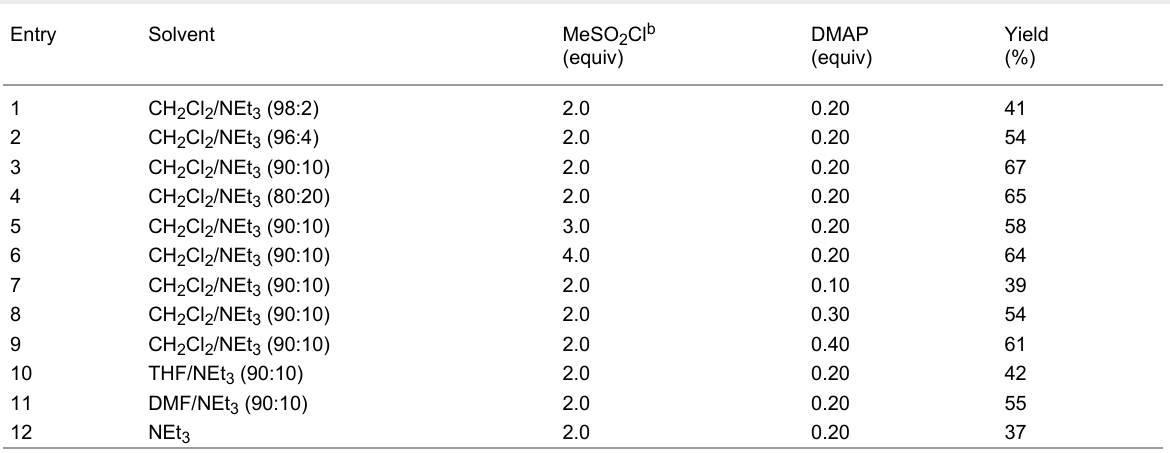
Table 1: Synthesis of 2a (0 °C → rt, 1 h) under different reaction conditions. a